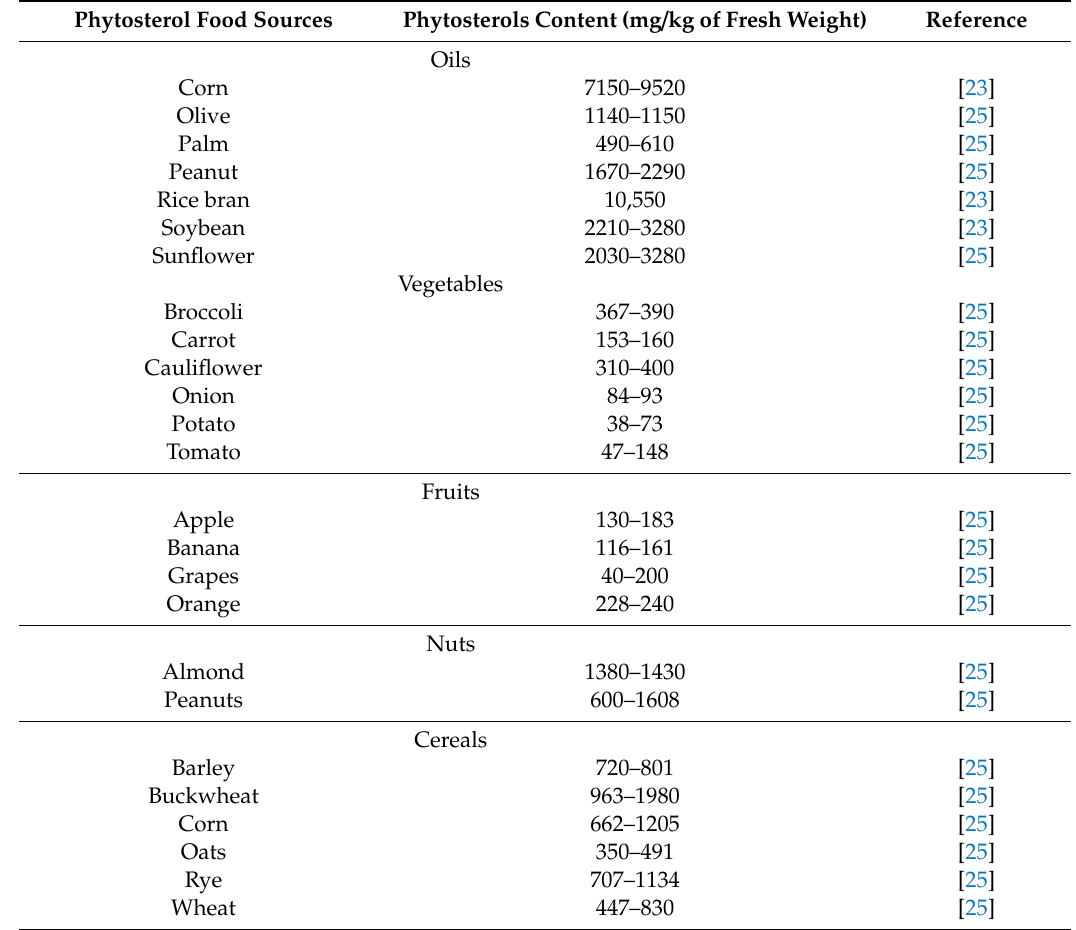
Table 1. Phytosterols’ food sources and their